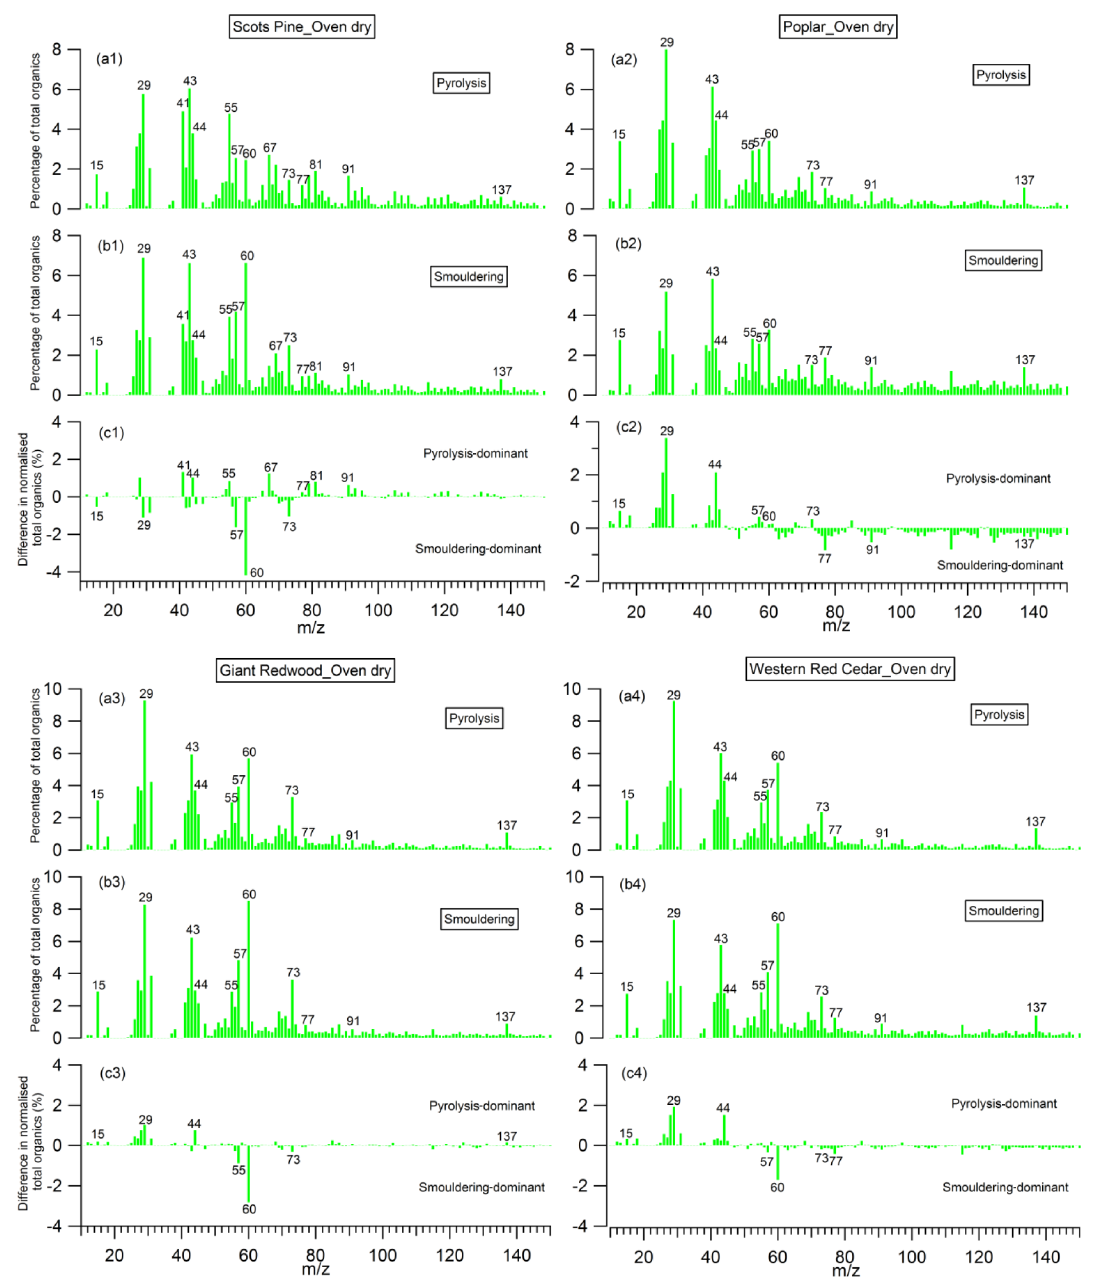
Figure 10. Mass spectra of organic aerosols (OA) presented as a percentage of total OA produced during (a) the pyrolysis phase and (b) the smouldering phase; and (c) the difference between them, for the dry wood